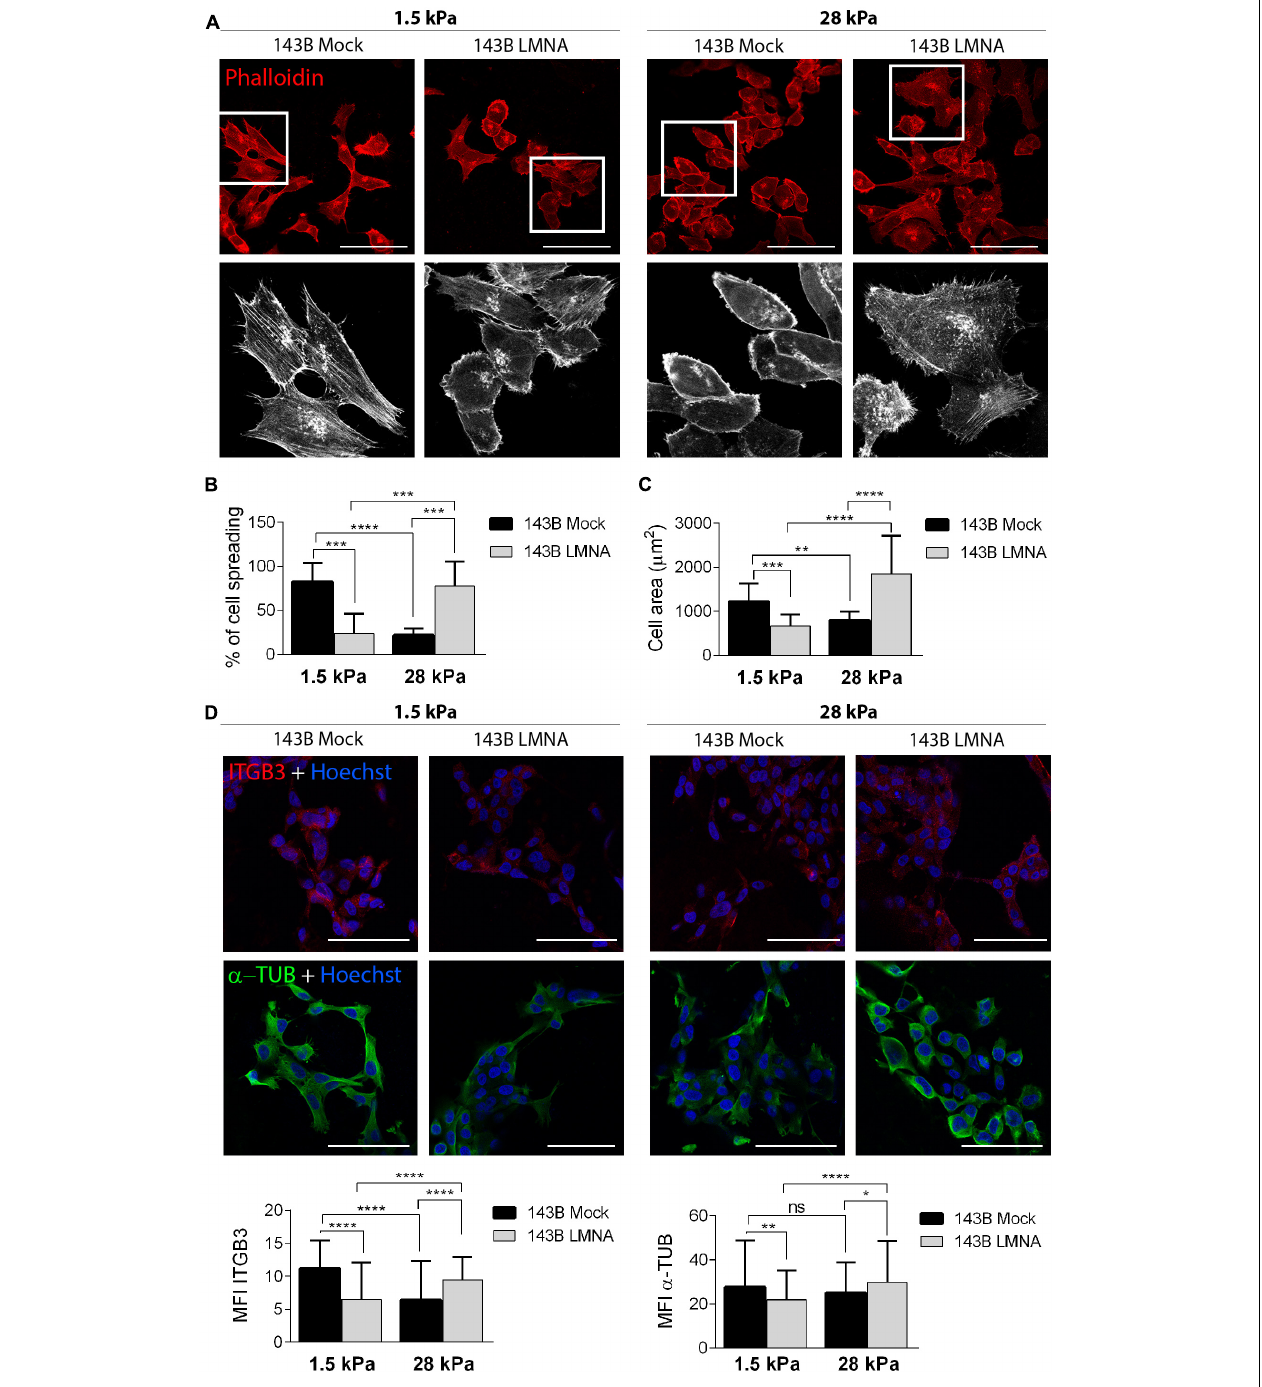
FIGURE 3 | Adhesion of 143B cells on PDMS substrates with different elasticity. (A) Confocal microscope representative pictures of 143B Mock and 143B LMNA cells stained with phalloidin (red) and cultured on PDMS substrates with a 1.5 and 28 kPa elasticity (upper panels). Bar: 100 µ m. n = 50. High magnification of the boxed area showing phalloidin staining pseudo-colored in white to improve cell spreading details (lower panels). (B) Quantification of the percentage of cell spreading in 143B Mock and 143B LMNA cells cultured on the 2 different PDMS substrates. (C) Measurement of the cell area of 143B Mock and 143B LMN-A cells cultured on the 2 different PDMS substrates. ** p < 0.01; *** p < 0.005; **** p < 0.001. (D) Confocal microscope representative pictures of 143B Mock and 143B LMNA cells immunostained for ITGB3 (red), α -TUB (green) and counterstained with nuclear dye Hoechst (blue) and cultured on PDMS substrates with a 1.5 and 28 kPa elasticity (upper panels). Bar: 100 µ m. n = 50. Quantification of the mean fluorescence intensity (MFI) of ITGB3 and α -TUB in 143B Mock and 143B LMNA cells cultured on the 2 different PDMS substrates. ns, not significant; * p < 0.05; ** p < 0.01; **** p <